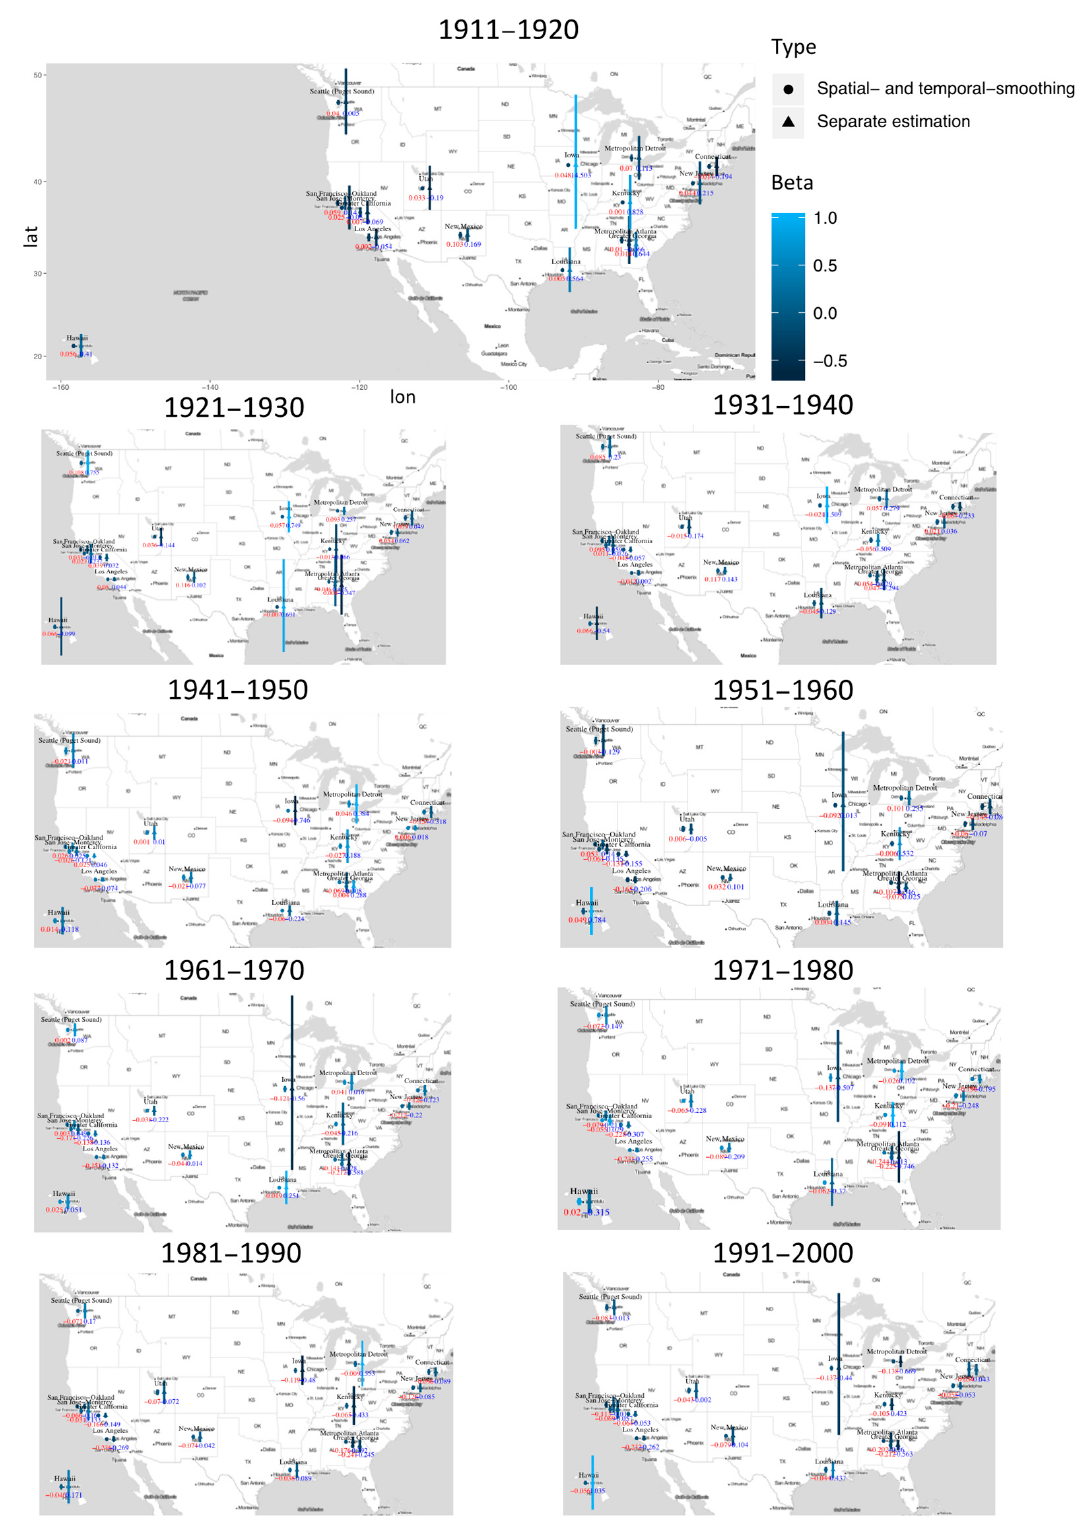
Figure 1. Representative analysis results using the proposed and separate estimations: estimated coe ffi cient (circle or triangle) and its 95% confidence interval (vertical bar) for race (White) at each time interval and location.